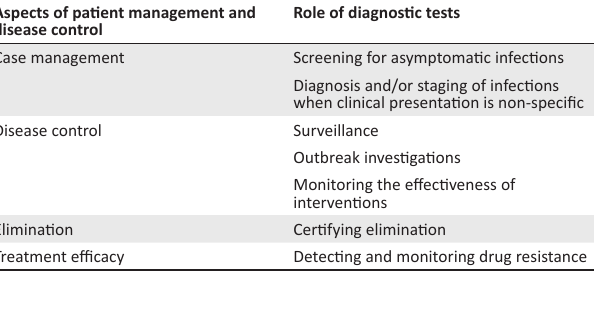
TABLE 1: Role of diagnostic tests in patient management and disease control. Aspects of patient management and disease